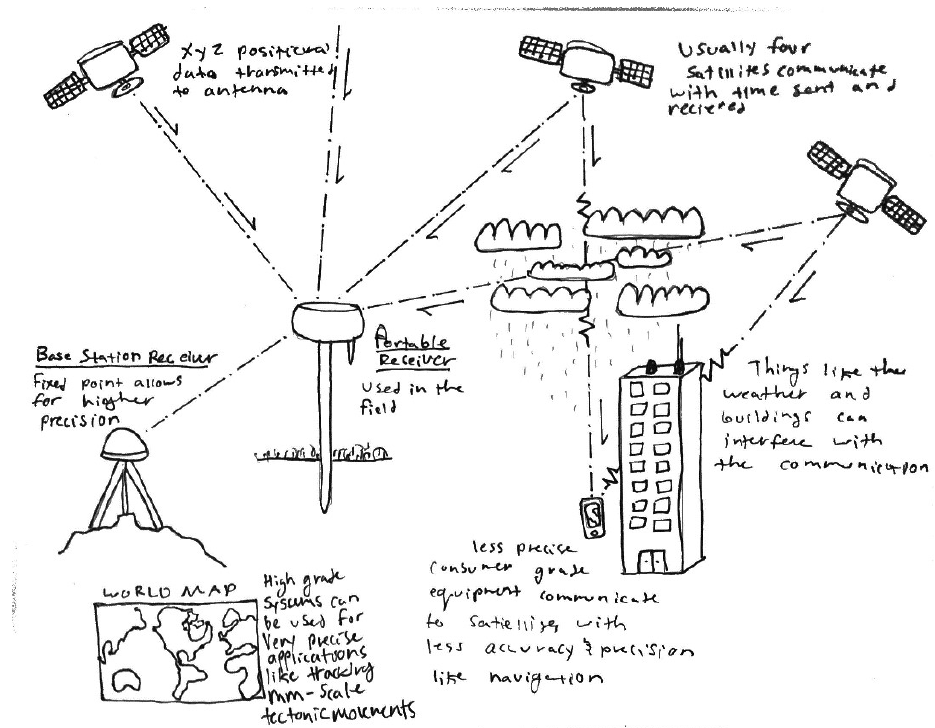
Figure 4. Student sketch of how GNSS works, including disruptions and applications thereof demonstrating theoretical understanding of GNSS (created by student in course for Day 2 activity; student name not disclosed to comply with Institutional Review